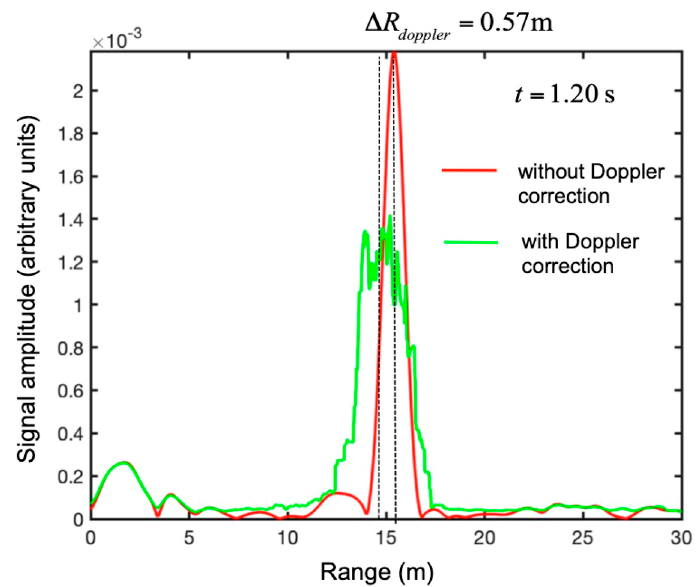
Figure 24. Maneuver 2 (i.e., rapid take-off). Range plots at time 1.20 s without the Doppler correction ( in red ) and with the Doppler correction ( in green ).